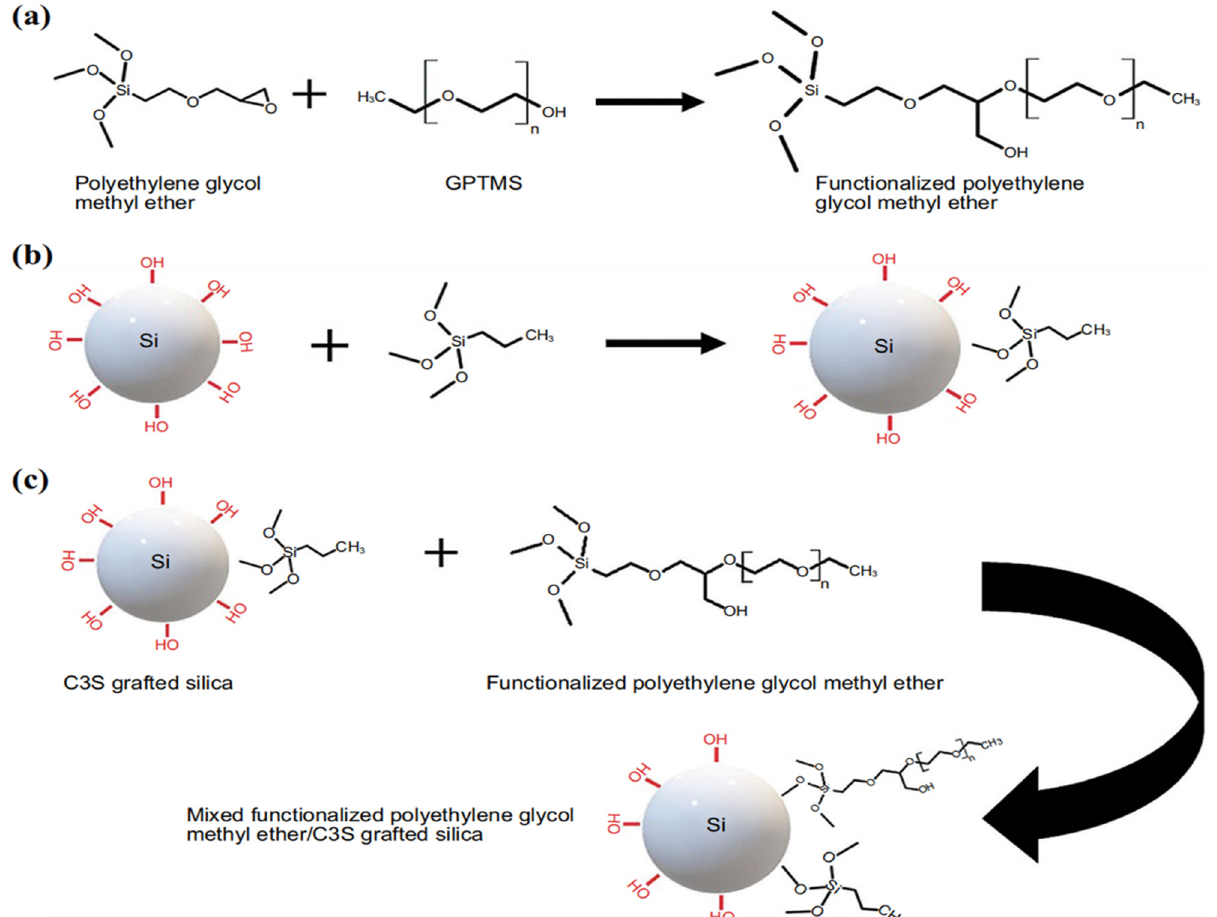
Figure 2: Chemical reaction steps: ( a ) the functionalized polyethylene glycol methyl ether by GPTMS, ( b ) the modi fi ed silica by trimethoxy ( propyl ) silane ( C3S ) , and ( c ) the addition of functionalized polyethylene glycol methyl ether on the surface of the modi fi ed silica with C3S [ 88 ]